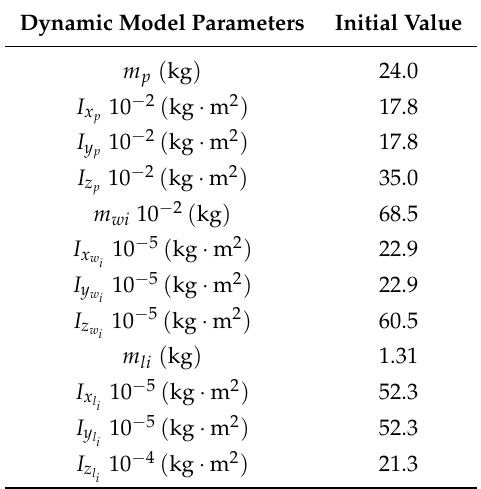
Table 1. Initial dynamic model parameters of 6-RSS parallel robot.